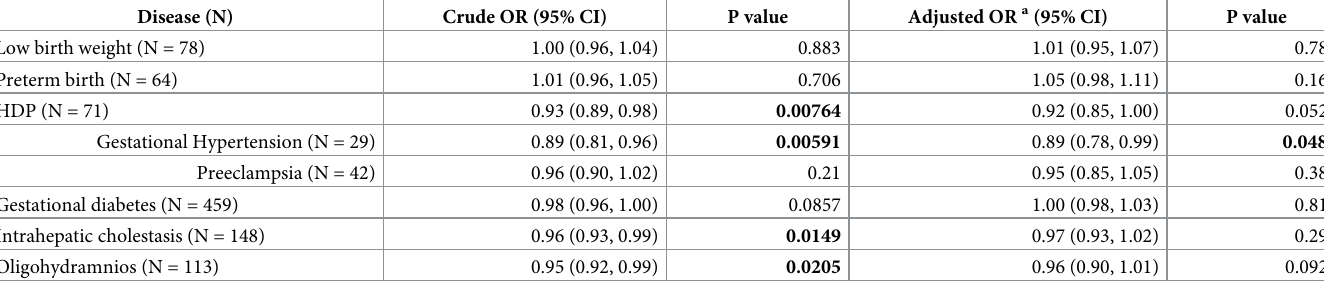
Table 2 shows associations between continuous fetal fractions and the pregnancy outcomes. The increase of fetal fraction had significant protective effects on hypertensive disorder of pregnancy (HDP), intrahepatic cholestasis and oligohydramnios. When dividing HDP into gestational hypertension and preeclampsia, a significant association was only observed for ges- tational hypertension. After adjusting for BMI, maternal age and gestational age at NIPT, only Table 2. Relationships between fetal fraction (continuous variable) and pregnancy-related complications. Disease